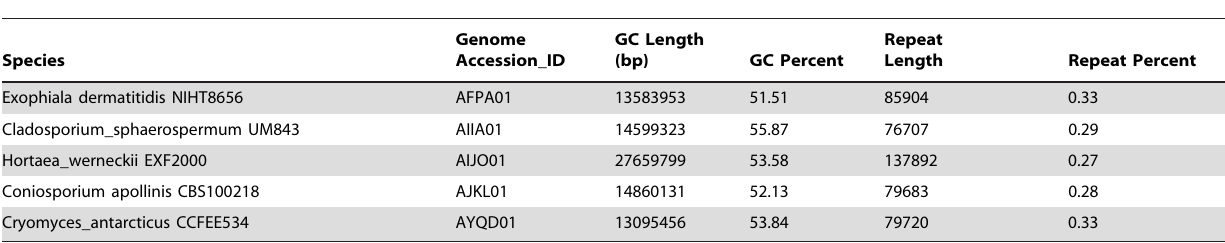
Table 2. GC content and repetitive sequences in Cryomyces antarcticus.